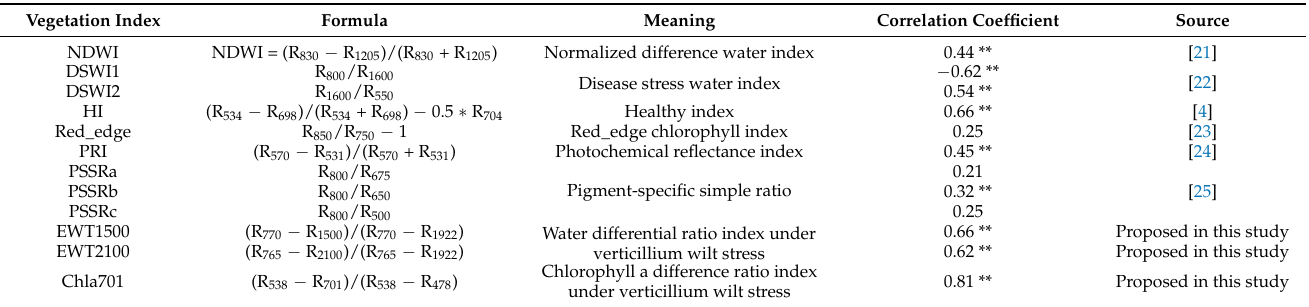
Table 3. Correlation between classical vegetation indices and disease levels. * indicates a significant level of 0.05; ** indicates a significant level of 0.01; r0.05 = 0.272; r0.01 = 0.322.